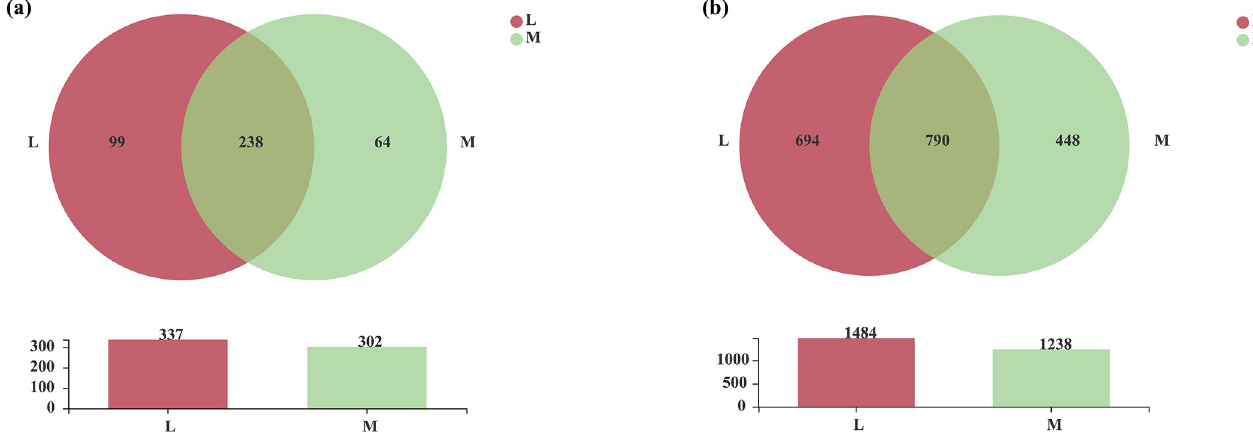
Fig 14. Venn analysis of soil fungi between moss- (M) and non-moss growth (L)areas at the genus (a) and OTU (b) levels in litchi orchard.